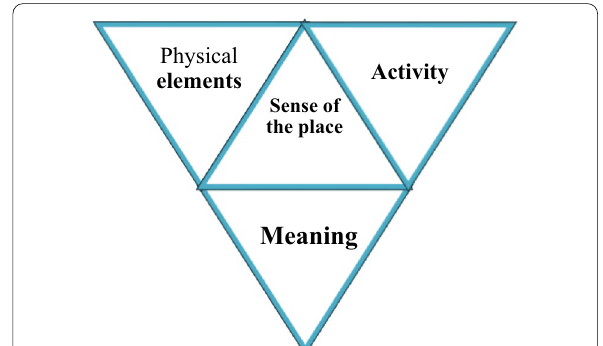
Fig. 2 Sense of place and relation with activities, physical setting and meaning, Source: (Relph